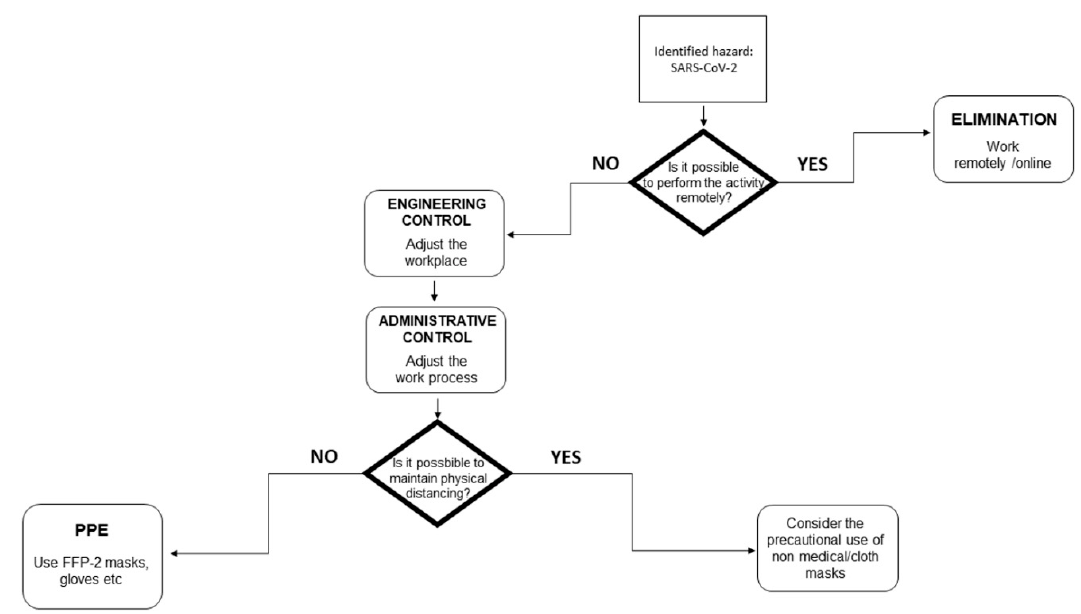
Figure 2. Decisional flowchart for the managing of the Hierarchy of Controls to mitigate SARS-CoV-2. The flowchart shows the steps as boxes and their order by connecting the boxes with arrows. The boxes with rhombus shapes are decisional steps.